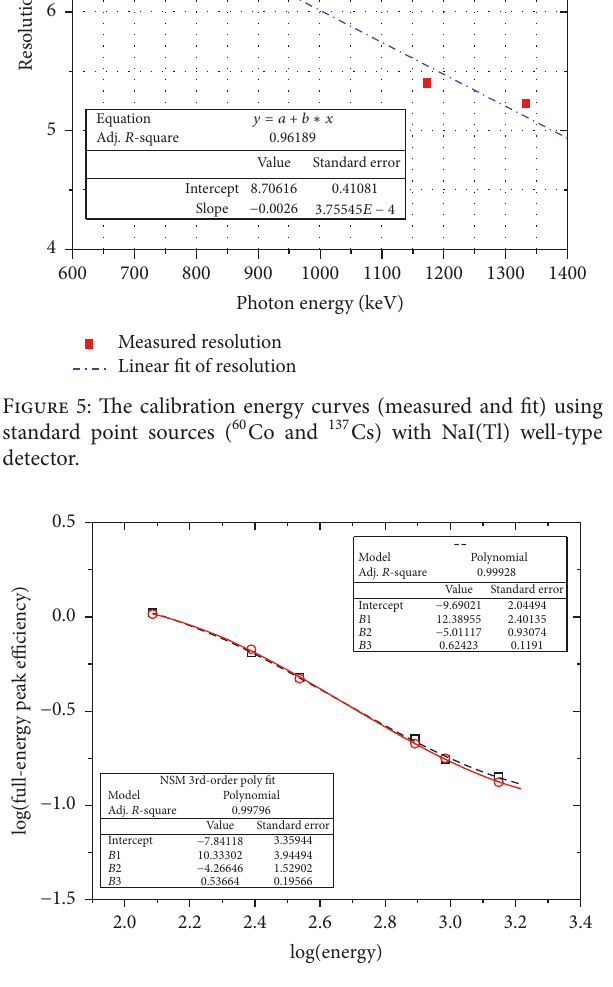
Figure 6: The variation of the calculated photopeak efficiency of 7.62 × 7.62 cm 2 NaI(Tl) well-type sodium iodide detector as a function of photon energy. Square symbols are the experimental present work; red solid line and its circles represent the values calculated using Abbas formulae [4] and dashed line is the